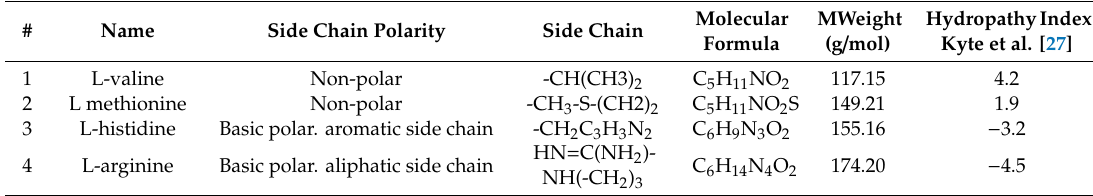
Table 1. Classification of selected amino acids and their chemical formula.